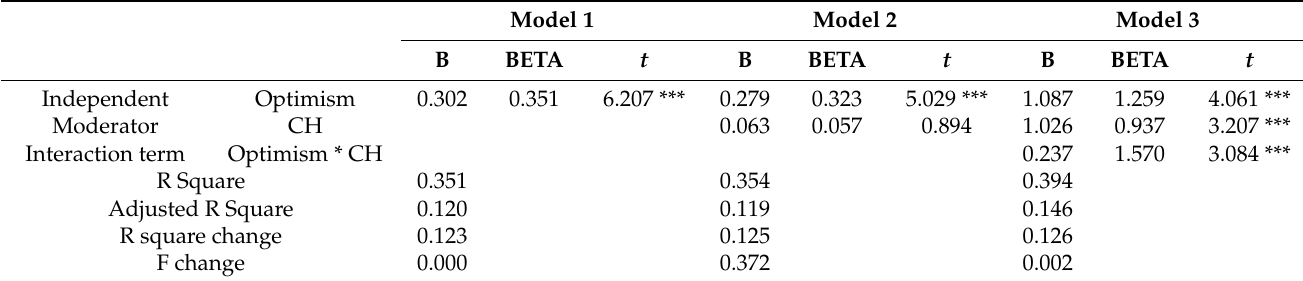
Table A4. Hierarchical regression for the moderation analysis: the moderating effect of coping humor on the path between optimism and the re-entry intention.